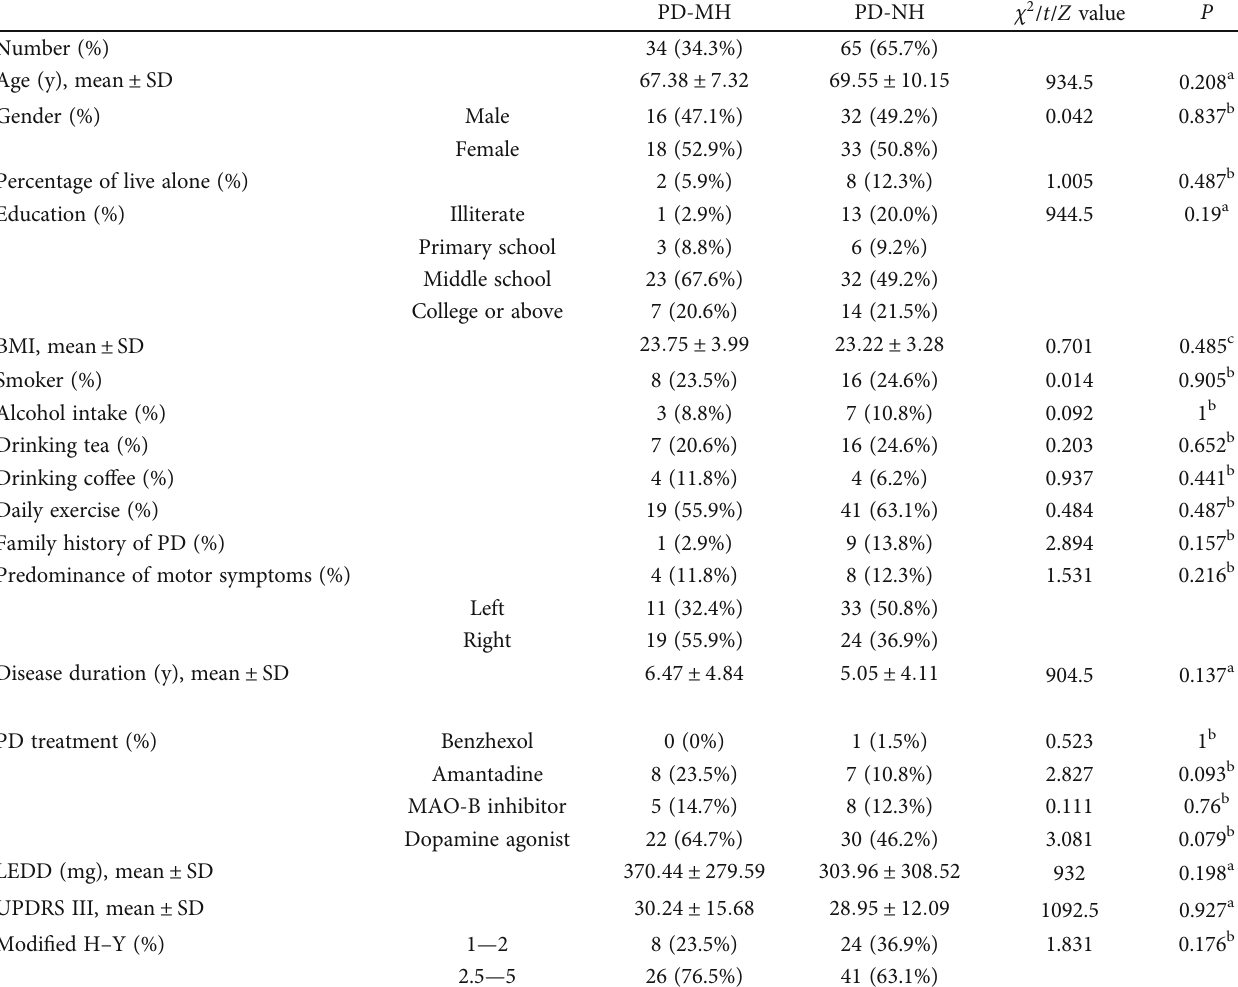
Table 1: Demographic parameters in the PD-MH and PD-NH